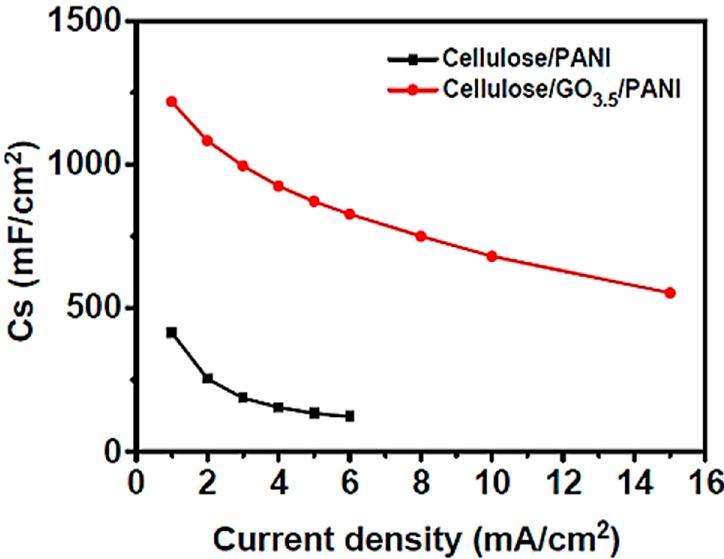
Figure 14. Plots of areal specific capacitance vs. current for cellulose/polyaniline and cellu- lose/graphene oxide/polyaniline [128]. Reproduced with permission from MDPI.